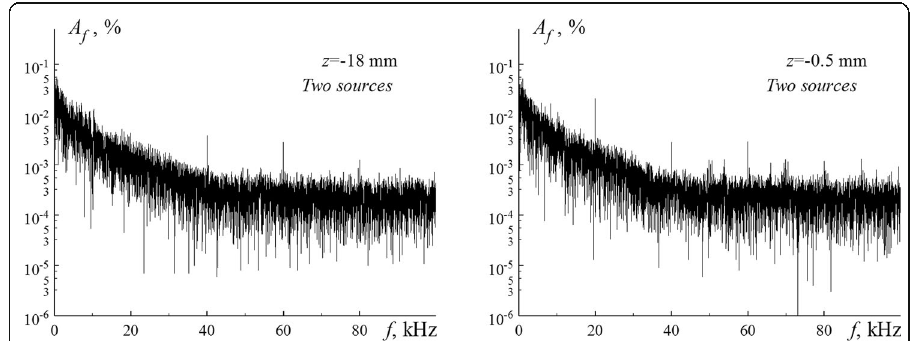
Fig. 8 Amplitude spectra of the total pulsations at x = 80 mm and z = − 18 mm (left), z = − 0.5 mm